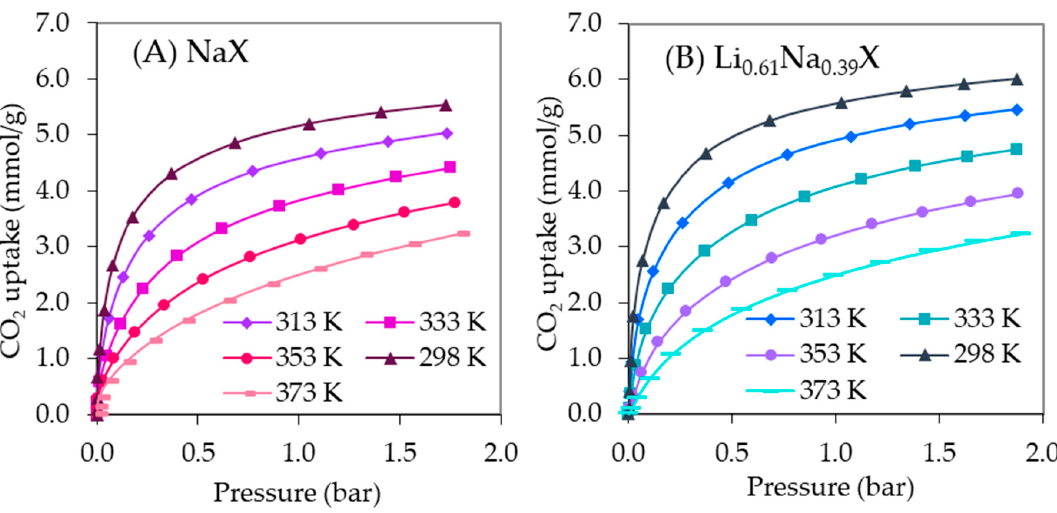
Figure 10. CO 2 adsorption isotherms at different temperatures for the NaX ( A ) and Li 0.61 Na 0.39 X ( B ) samples. Table 6. Constant values of the Sips isotherms of CO 2 adsorption on NaX. Two and three parameter adsorption models (Freundlich, Langmuir, Toth, Sips) were used to describe equilibrium data of Li 0.61 Na 0.39 X and NaX, respectively, at different temperatures. The parameters of the equations were calculated by minimizing the sum of the squares of the errors. The solver add-in with Microsoft’s spreadsheet, Excel 2013, was used for calculations. It was found that the Sips isotherms gave the highest accuracy in fitting the experimental data for Li 0.61 Na 0.39 X and NaX. Tables 6 and 7 list Sips isotherm parameters for different temperatures for NaX and